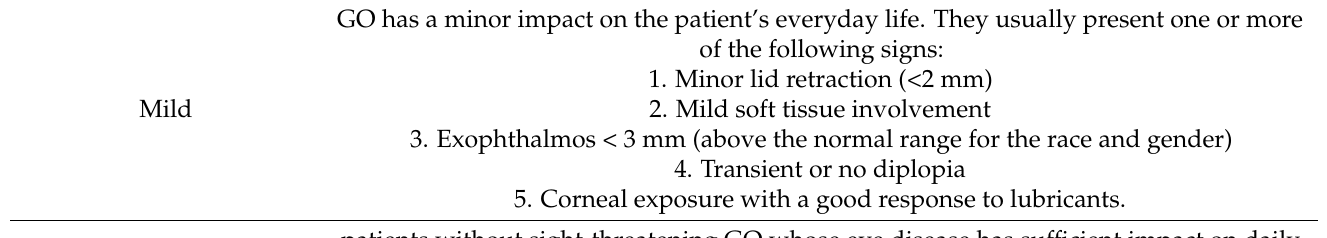
Table 6. This is a table. Severity classification of GO. The management of patients depends on the severity which is established according to the impact of the disease on the patient’s quality of life and the risk of vision loss. The disease is classified as mild, moderate, severe, or sight-threatening as follows [1].